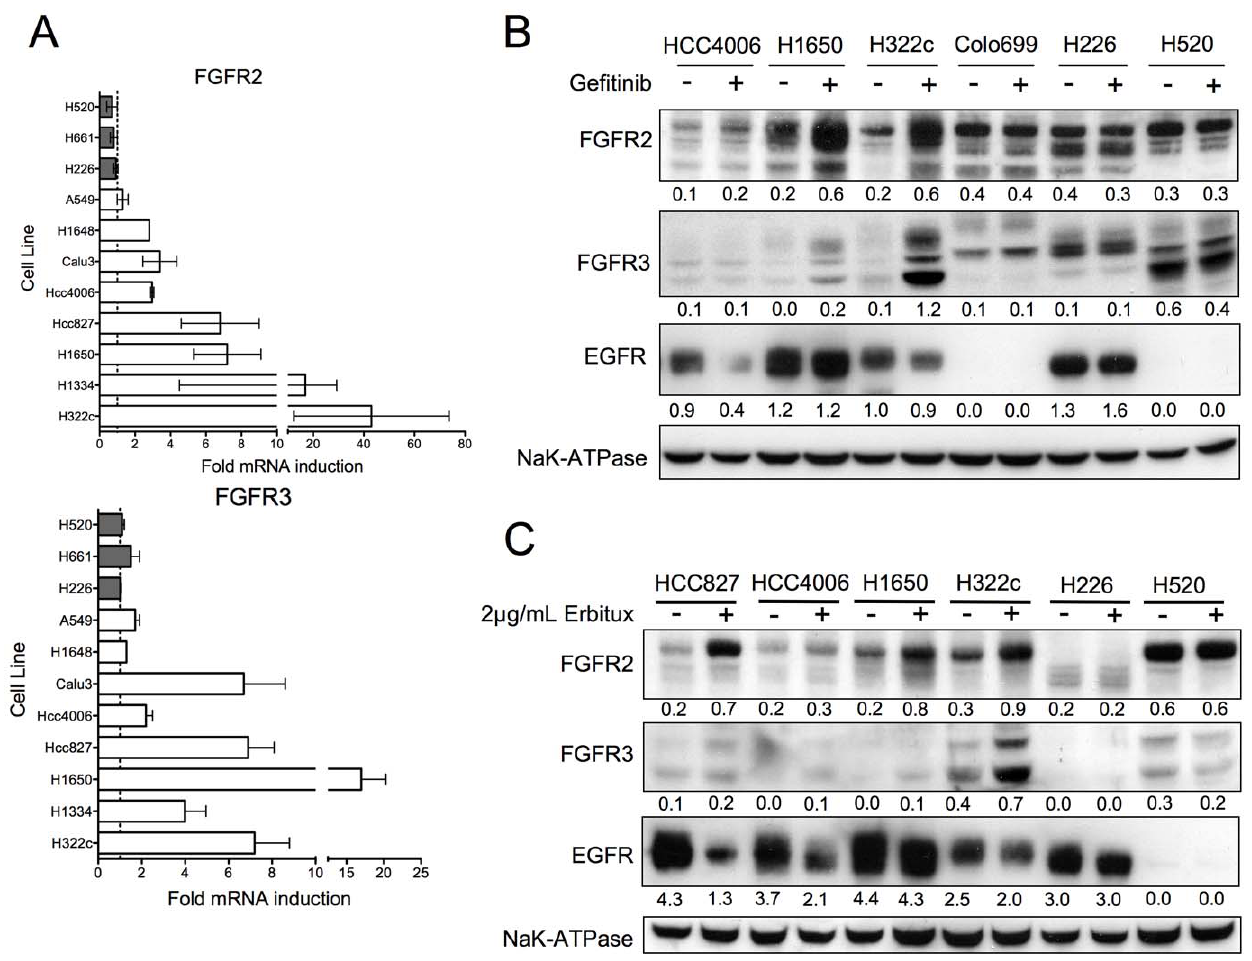
Figure 1. Induction of FGFR2 and FGFR3 mRNA and protein in EGFR inhibitor treated NSCLC cells. A. Quantitative RT-PCR assay for FGFR2 and FGFR3 mRNAs. Total RNA was purified from the indicated cell lines following a 3-day treatment with 1 m M gefitinib and submitted to quantitative RT-PCR analysis of FGFR2, FGFR3 and GAPDH. (Cell lines with EGFR autocrine signaling or gain-of-function EGFR mutations: open bars; cell lines lacking EGFR signaling: grey bars) The data are presented as fold expression over DMSO treated cells following normalization for GAPDH mRNA. B–C. Cell lysates from the indicated NSCLC cell lines treated 3 days with or without 1 m M gefitinib or 2 m g/mL Erbitux were immunoblotted for FGFR2, FGFR3, EGFR and the a -subunit of the NaK-ATPase as a loading control. Densitometry of FGFR2, FGFR3 and EGFR expression was normalized relative to NaK-ATPase expression and is indicated under each immunoblot.